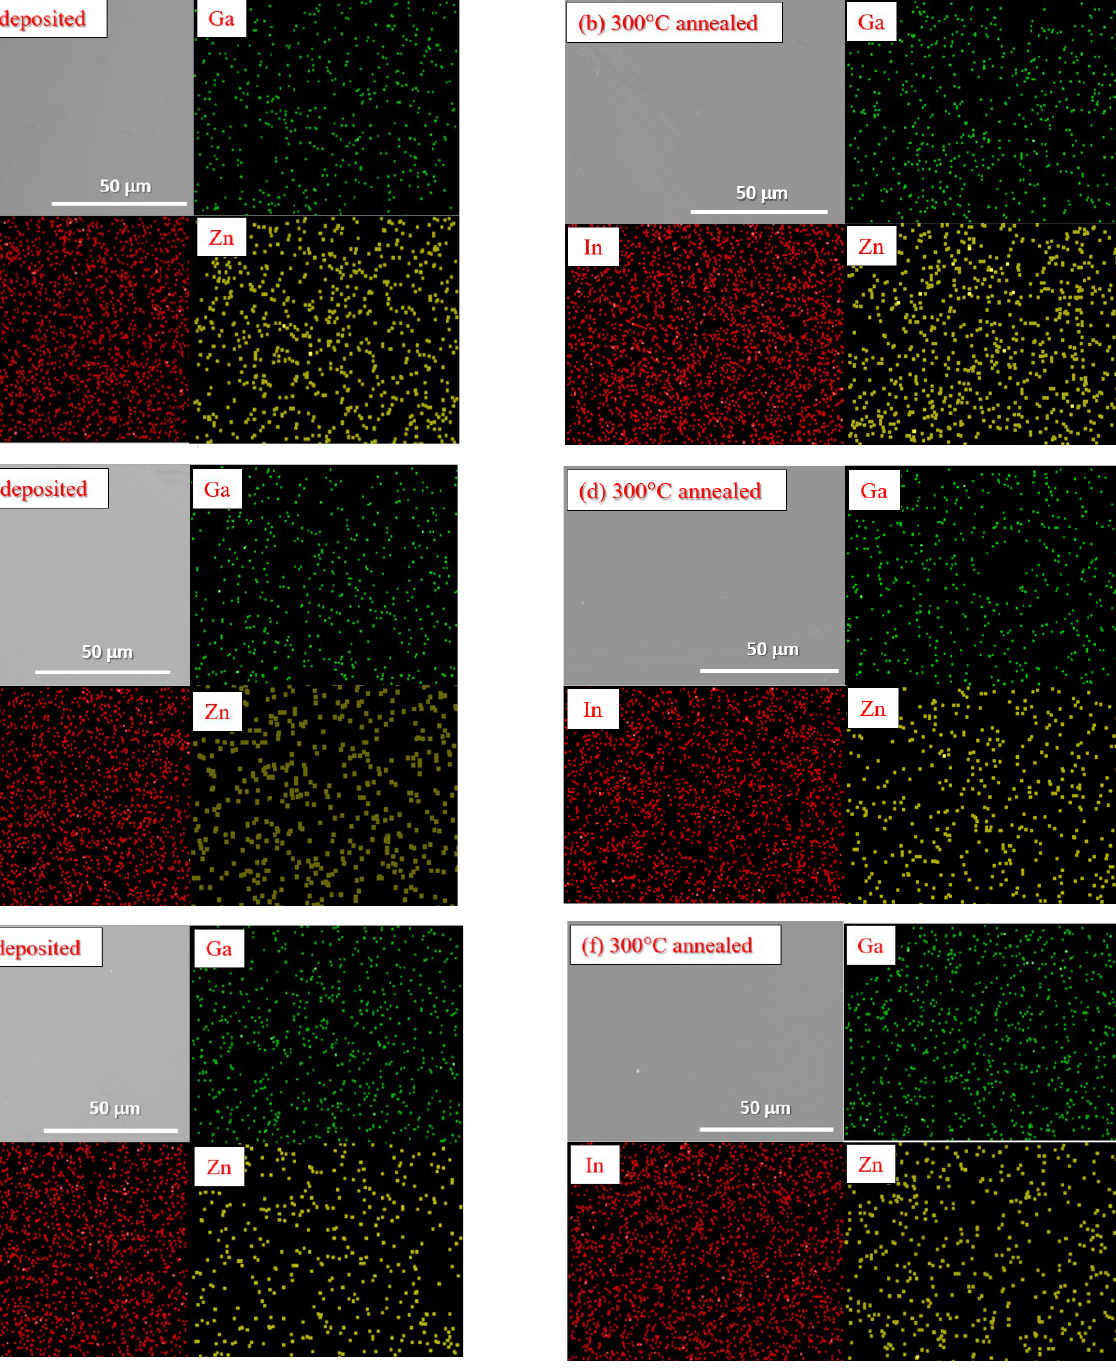
Figure 7. SEM micrographs and EDS element mappings of the three types of a -IGZO layers deposited with Ar:O 2 = 20:1.2 (sccm). ( a ) as-deposited and ( b ) 300 ◦ C-annealed a -InGaZn 2 O 5 layers; ( c ) as- deposited and ( d ) 300 ◦ C-annealed a -InGaZnO 4 layers; ( e ) as-deposited and ( f ) 300 ◦ C-annealed a -InGa 2 ZnO 5.5